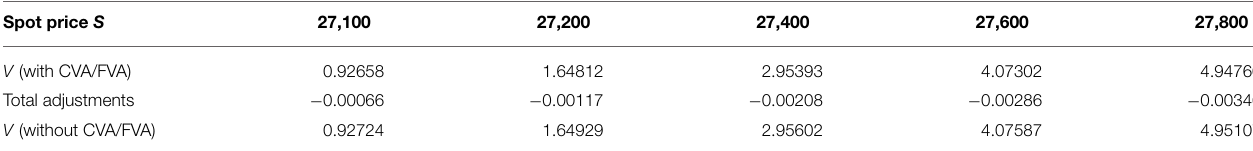
TABLE 12 | Prices of down-and-out put under KoBoL process as of 28 May 2015, time to maturity T = 0 . 0877 , spot S = 27 , 454 . 31 , strike K = 27 , 400 , barrier H = 27 , 000 , risk-free rate r = 0 . 25 % , collateral rate r C = 1 % , funding rate r F = 1 . 7 % default intensity λ = 0 . 05 , recovery rate R B = 0 . 4 , collateral threshold H B = 0 . 1 , CPU time: 16.64s.